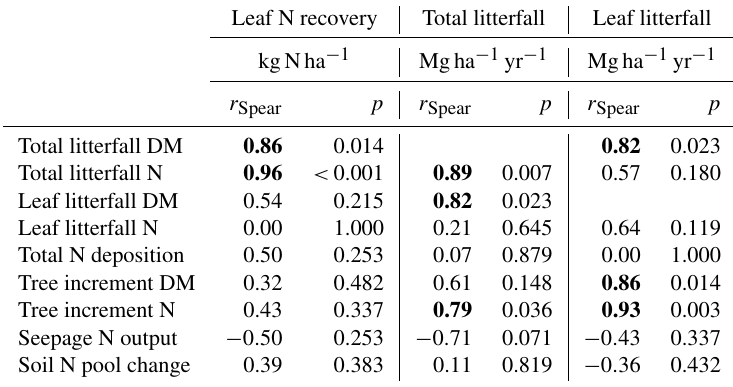
Table 6. Correlation analyses (Spearman correlation coefficients, r Spear , p ) between leaf N recovery, total litterfall, leaf litterfall, and the input and output fluxes of nitrogen (N) and biomass (DM, dry mass). Significant correlations ( p < 0 . 05) are indicated by bold